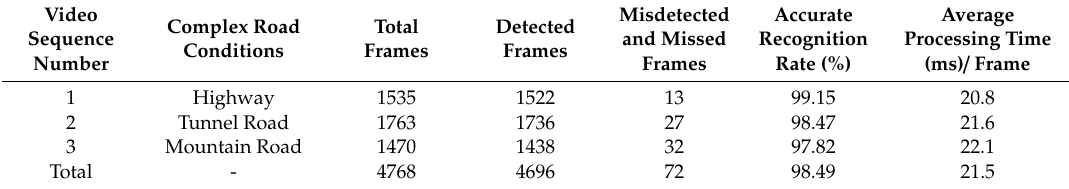
Table 1. The lane detection results based on road driving video under complex road conditions.